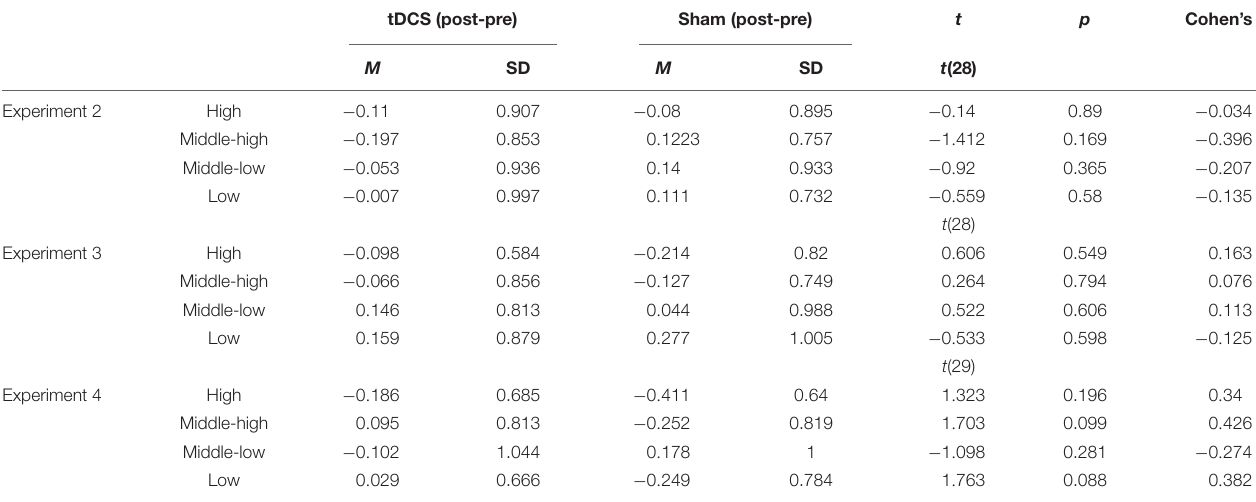
TABLE 1 | Difference of mean rating scores between pre- and post-stimulation in the high, middle-high, middle-low, and low image cluster in the tDCS and sham condition. tDCS (post-pre) Sham (post-pre) t p Cohen’s